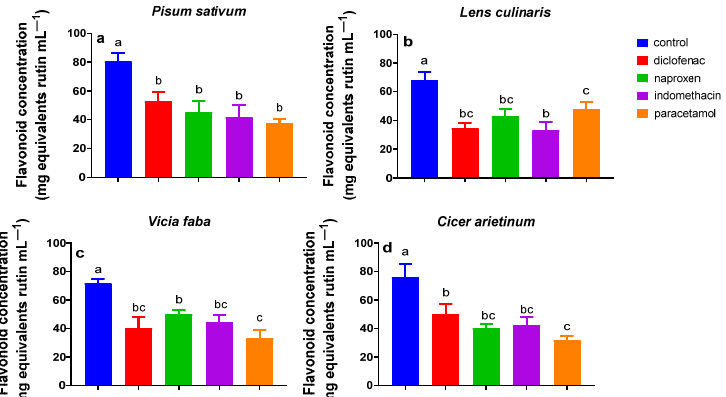
Figure 8. Flavonoids concentration from Pisum sativum ( a ), Lens culinaris ( b ), Vicia faba ( c ), and Cicer arietinum ( d ). Plants in 0.5 L pots filled with commercial garden soil were treated by watering 100 mL of 0.5 mg L − 1 NSAIDs every second day over a total of 20 days. The plants were treated for ten days. The values are averages of three independent measurements. Data sharing different letters are significantly different ( p < 0.05), while data sharing the same letters are not significantly different ( p > 0.05).